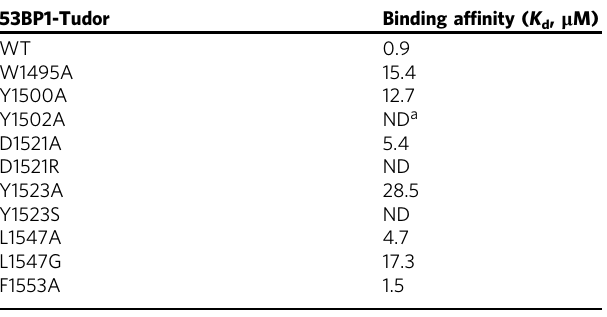
Table 3 Effects of 53BP1 Tudor mutation on TIRR binding